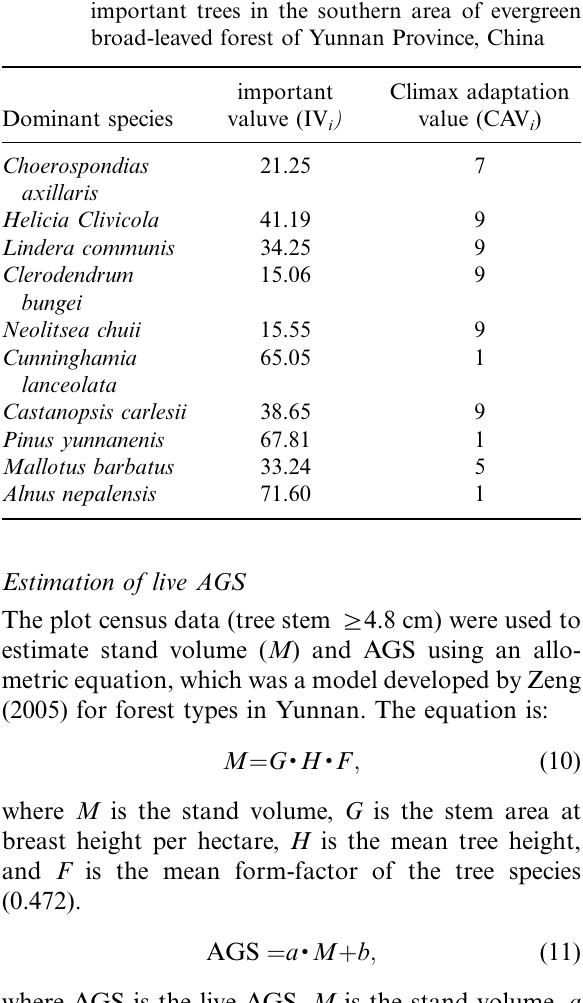
Table 2. The climate adaptation values (CAV i ) of relatively important trees in the southern area of evergreen